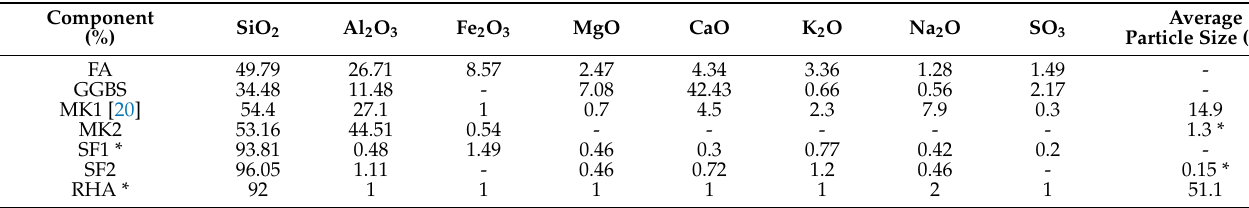
Table 1. Chemical compositions of source materials.